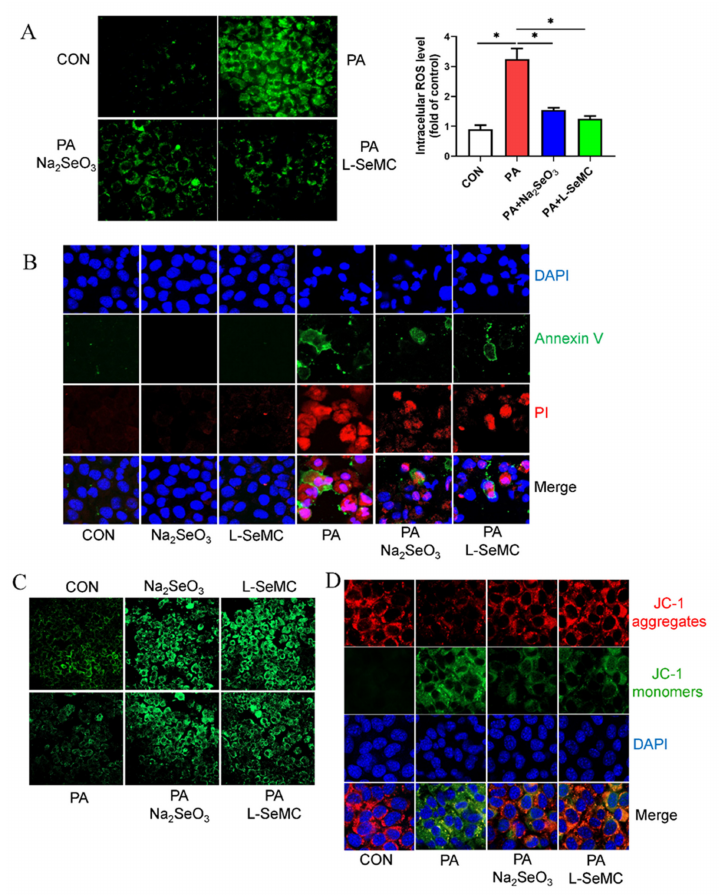
Figure 4. Effects of Na 2 SeO 3 and L-SeMC on oxidative stress in PA-induced AML-12 cells. ( A ) ROS content detection in AML-12 cells after co-treatment with PA with or without Na 2 SeO 3 and L- SeMC for 24 h, including images (400 × magnification) and fluorescence density analysis ( n = 3, * p < 0.05). ( B ) The apoptosis of AML-12 cells was determined by Annexin V/PI apoptosis staining kit after co-treatment with PA with or without Na 2 SeO 3 and L-SeMC for 24 h (200 × magnification). ( C ) Mitochondrial content was measured by Mito traker green after co-treatment with PA with or without Na 2 SeO 3 and L-SeMC for 24 h (400 × magnification). ( D ) Mitochondrial membrane